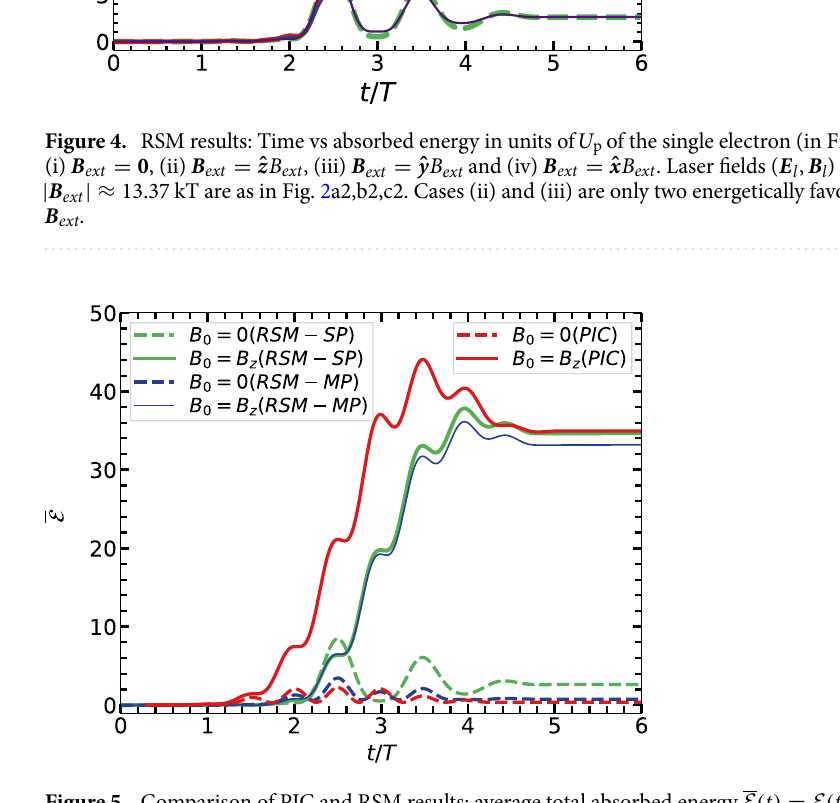
Figure 5. Comparison of PIC and RSM results: average total absorbed energy E ( t ) 0 (dashed lines, conventional case of Fig. 1a2,b2,c2) and with B ext in U p vs t / T with B ext = ECR case of Fig. 2a2,b2,c2). RSM results with single-electron (RSM-SP) and non-interacting multi-electrons (RSM-MP) both justify PIC results. Though absorption starts early in PIC, final absorbed energies E A with/without B ext are comparable with the RSM